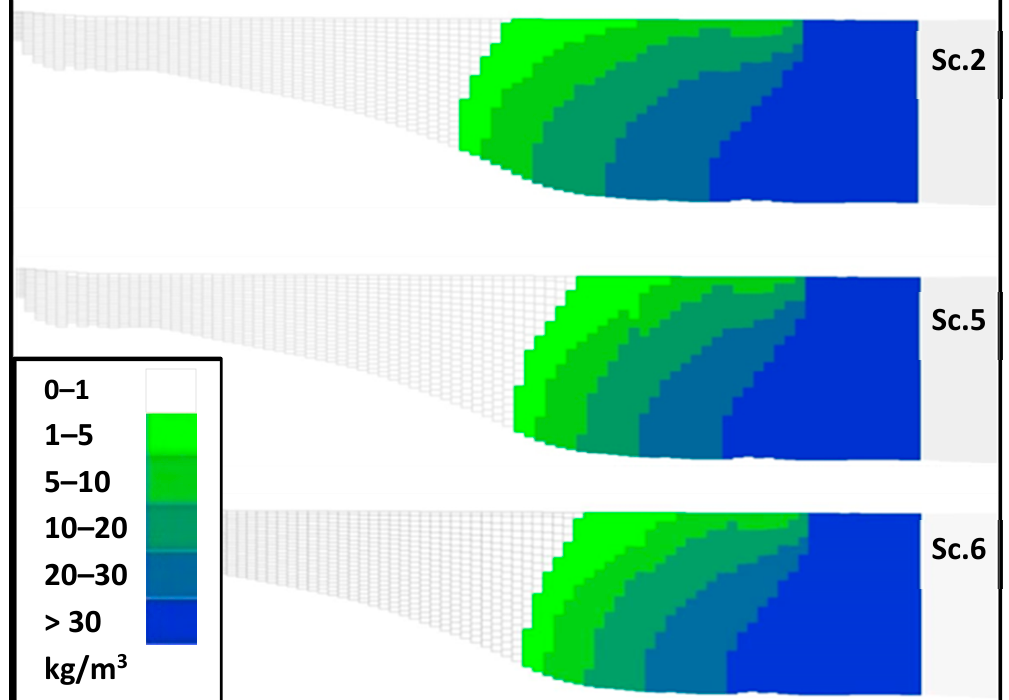
Figure 5. Cross-sections in the middle of the Nile Delta with different salinity distributions in different scenarios in the year 2100.